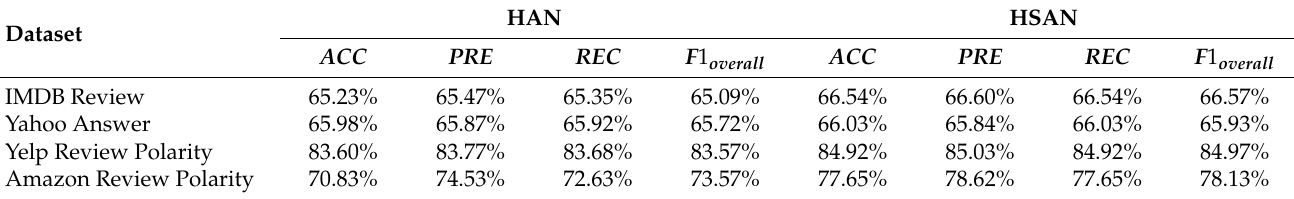
Table 9. Performance on four public datasets with the English